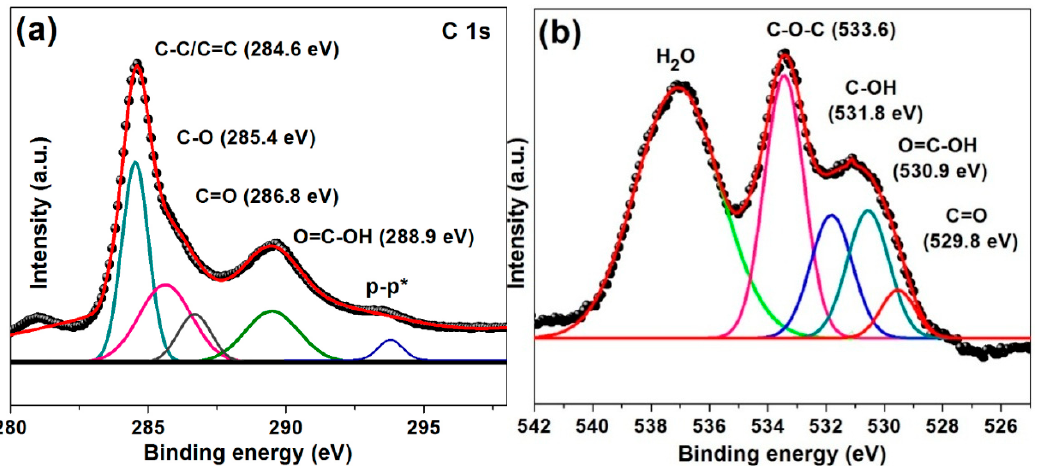
Figure 6. Deconvoluted XPS spectra of ( a ) C 1s and ( b ) O 1s peaks of fresh GO.